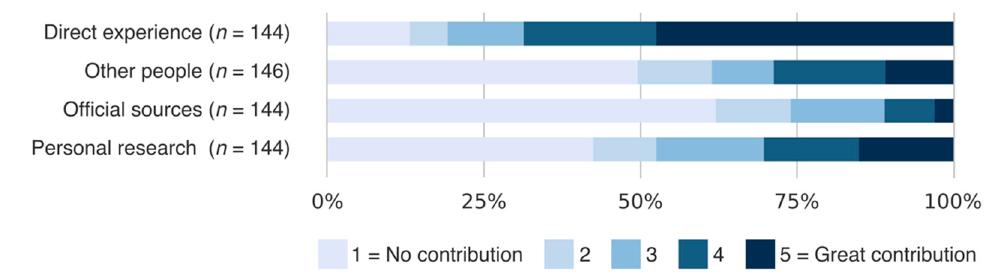
Figure 3. Survey results on self-assessed knowledge. 278